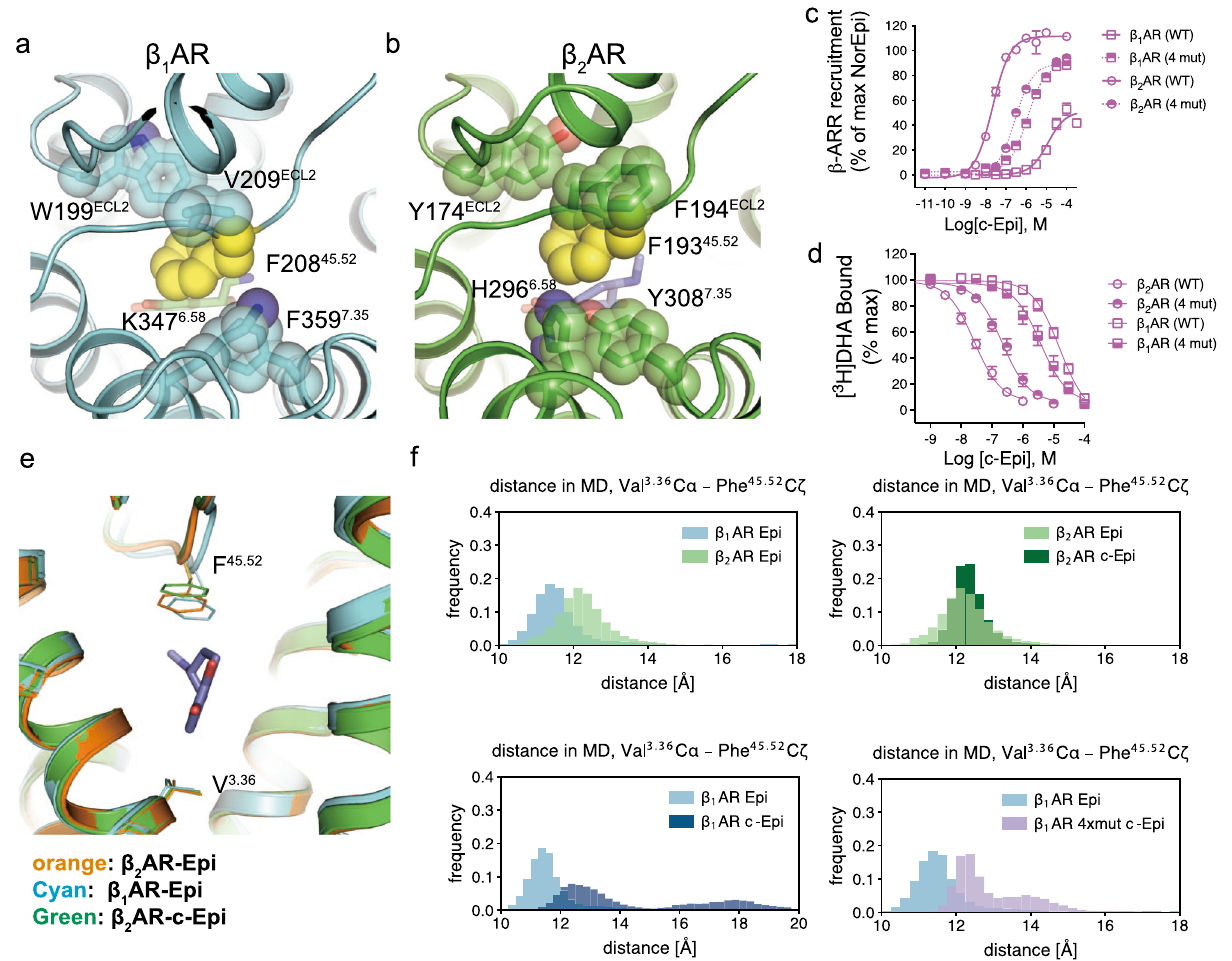
Fig.4|MutatingfourresiduesaroundtheF 45.52 affectc-Epiaf fi nitiesinthe β 1 AR and β 2 AR. a , b F 45.52 (yellow spheres) is conserved in the β 1 AR and β 2 AR, but is surrounded by differing residues.The differentsurrounding residuesare W199 ECL2 , V209 ECL2 , K347 6.58 , and F359 7.35 in the β 1 AR ( a ) and Y174 ECL2 , F194 ECL2 , H296 6.58 , and differentsimulationconditions.Thedistributionisshowninlightbluefor β 1 AR-Epi, dark blue for β 1 AR-c-Epi, light green for β 2 AR-Epi, dark green for β 2 AR-c-Epi and purplefor β 1 AR_4mut-c-Epi. C ζ of F 45.52 islocateddeeper in the pocket for β 1 AR-Epi comparedto β 2 AR-Epi,and β 1 AR-c-Epishowsasimilardistributionas β 1 AR-Epi.The deeper positionin β 1 AR cannotaccommodate for c-Epi and leads to adistortion